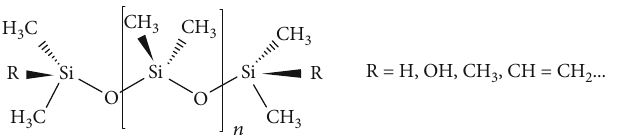
Figure 8: Structural formula of polydimethylsiloxane oligomer (PDMS). R is organic substituent at the end of the chain and n is a degree of